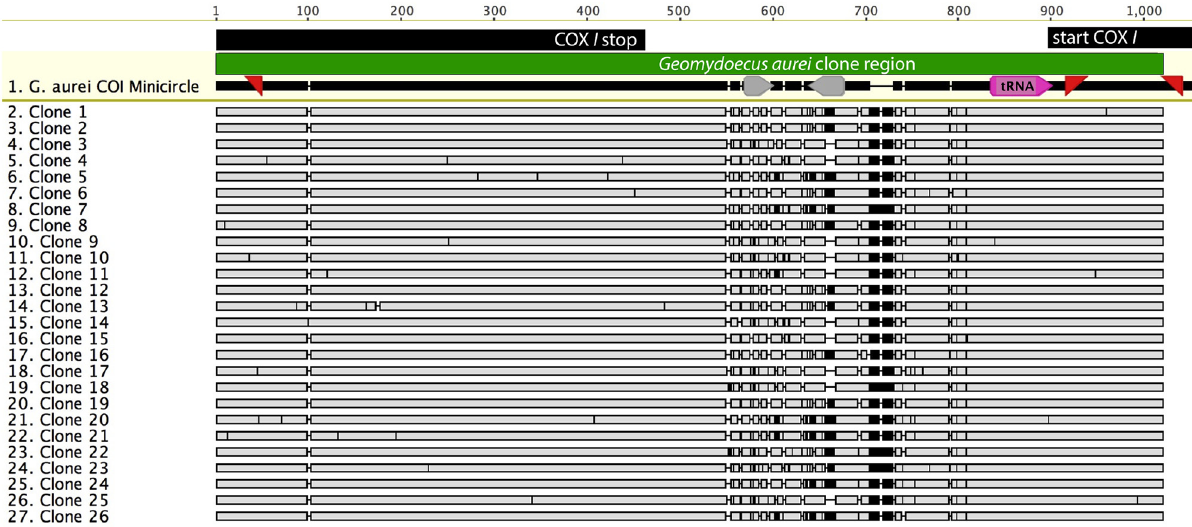
Fig 3. Alignment of Geomydoecus aurei Clones. Sequence 1: G . aurei COI minicircle is part of the full cox1 minichromosome from louse 1379.16 in Fig 1. This sequence is from a different individual than the clone sequences below it (individual 39.6.J) and was used as a reference to map the other clone sequences. At top, black bars indicate cox1 -coding regions, gray bars indicate inverted repeat regions, and pink indicates trn I . In clone sequences, vertical black marks represent differences in nucleotide composition, and horizontal bars indicate presumed insertion/deletion events in the alignment. Clone 12 and clone 19 are the only identical